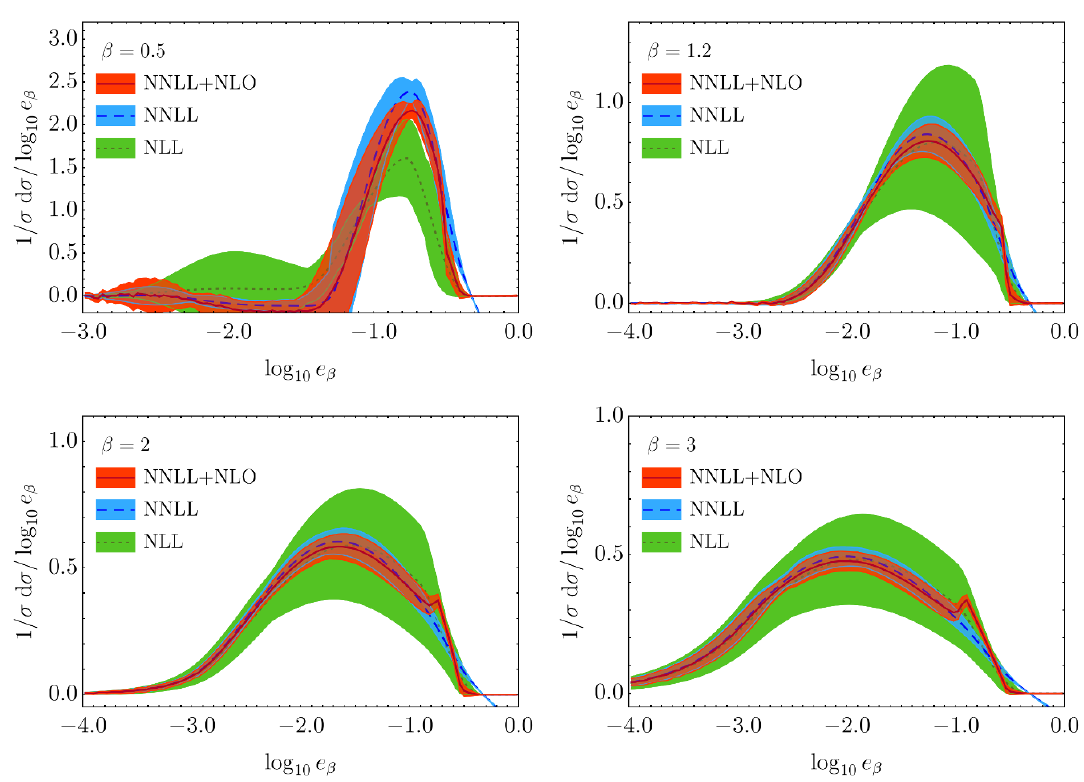
Figure 7 . Results for the NLL, NNLL and NNLL+NLO cross sections with uncertainties for four angularities (cid:12) = 0 : 5 ; 1 : 2 ; 2 and 3 (all normalized relative to the full NLO cross